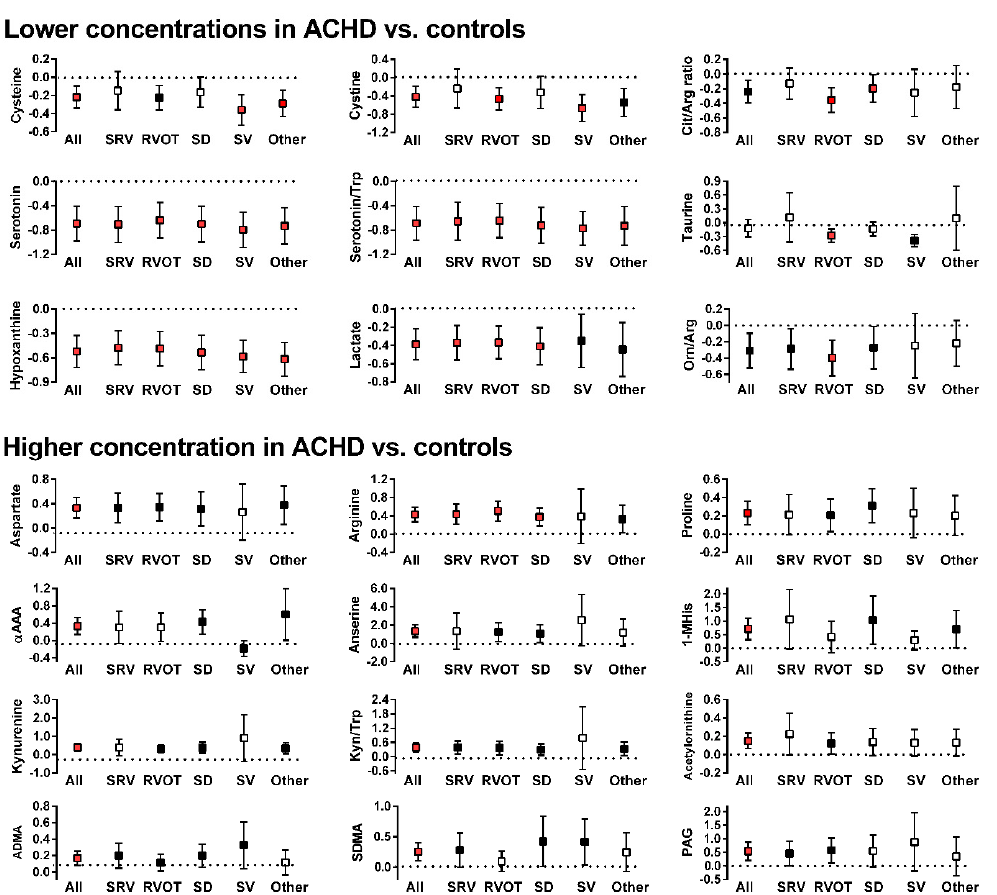
Figure 1. Significant differences in concentration of amino acids and related metabolic compounds between patients in any of the ACHD groups and controls (box represent the normalized differences along with 95% confidence interval; dotted line at x = 0 is the concentration in control subjects. White boxes: Difference is not statistically significant; black boxes: Difference is statistically significant but is above the threshold for a false discovery rate of 5%; red boxes: Difference is statistically significant and is below the threshold for a false discovery rate of 5%). Y-axis values indicate fold concentration difference between ACHD and controls for the indicated variable. x-axis abbreviations: ALL—all diagnoses; OTH—other diagnoses; SRV—transposition of the great arteries; RVOT—Tetralogy of Fallot/right ventricular outflow